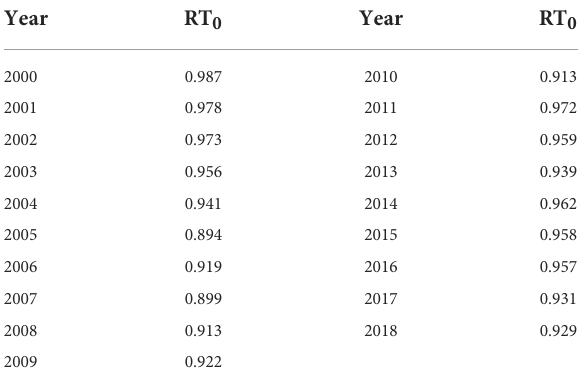
TABLE 7 Rationalization index of agricultural production structure in Xinjiang.